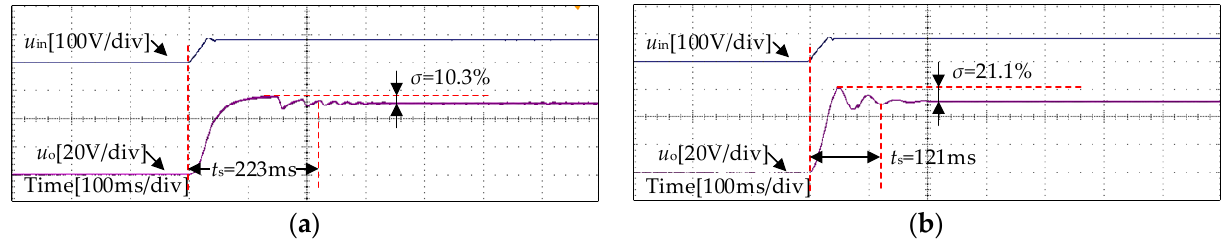
Figure 14. Starting process experimental waveforms: ( a ) with the traditional constant compensation control method; ( b ) with the proposed VDCC method.